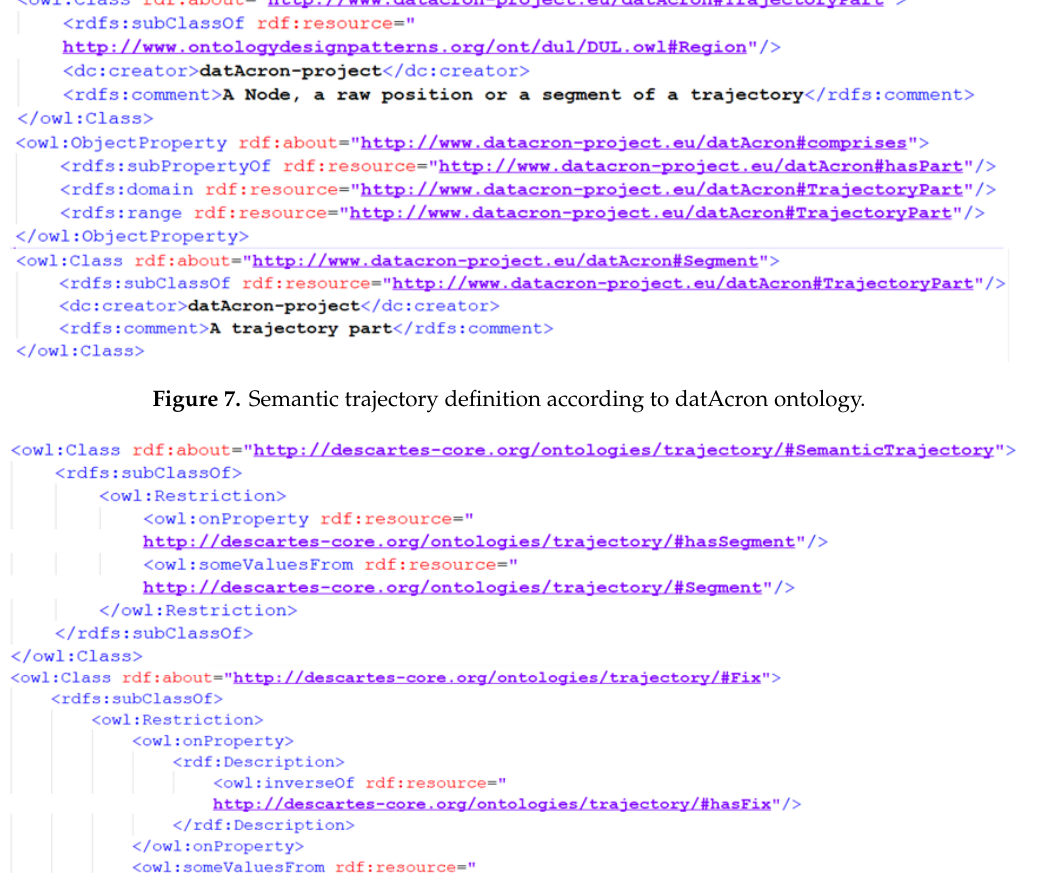
Figure 8. Definition of a semantic trajectory as a number of segments and fixes.